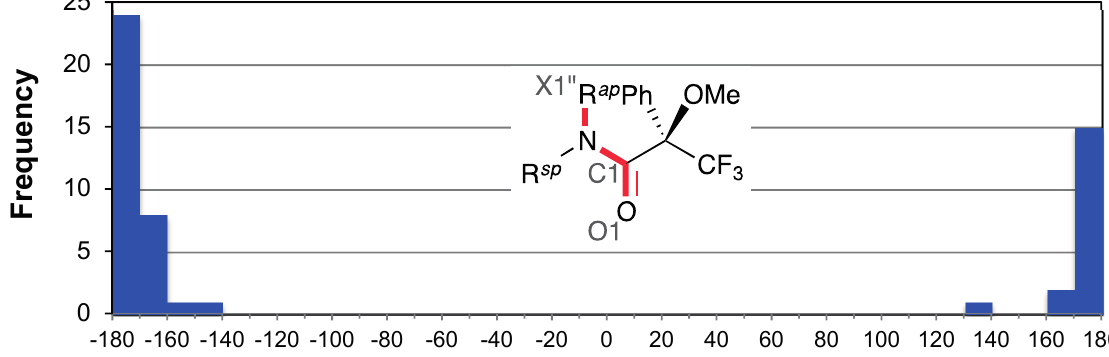
Figure 7. Histogram for dihedral angles X1 ′′ –N–C1–O1 of all MTPA amides. X1 ′′ is the α -atom of R ap , which is ap to the amide carbonyl group. The possible range of the dihedral angle X1 ′′ –N–C1–O1 is from − 180° to − 90° and from +90° to